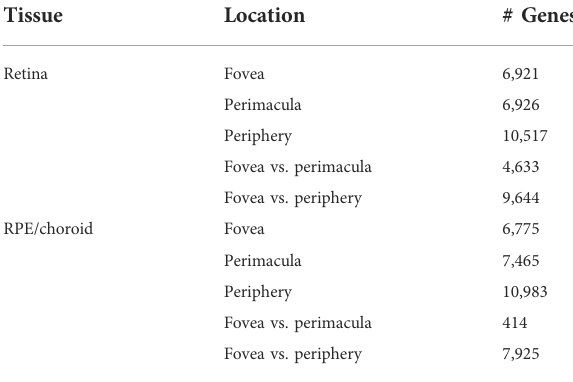
TABLE 1 A summary of the differential gene expression (padj < 0.05) in retina and RPE/choroid by